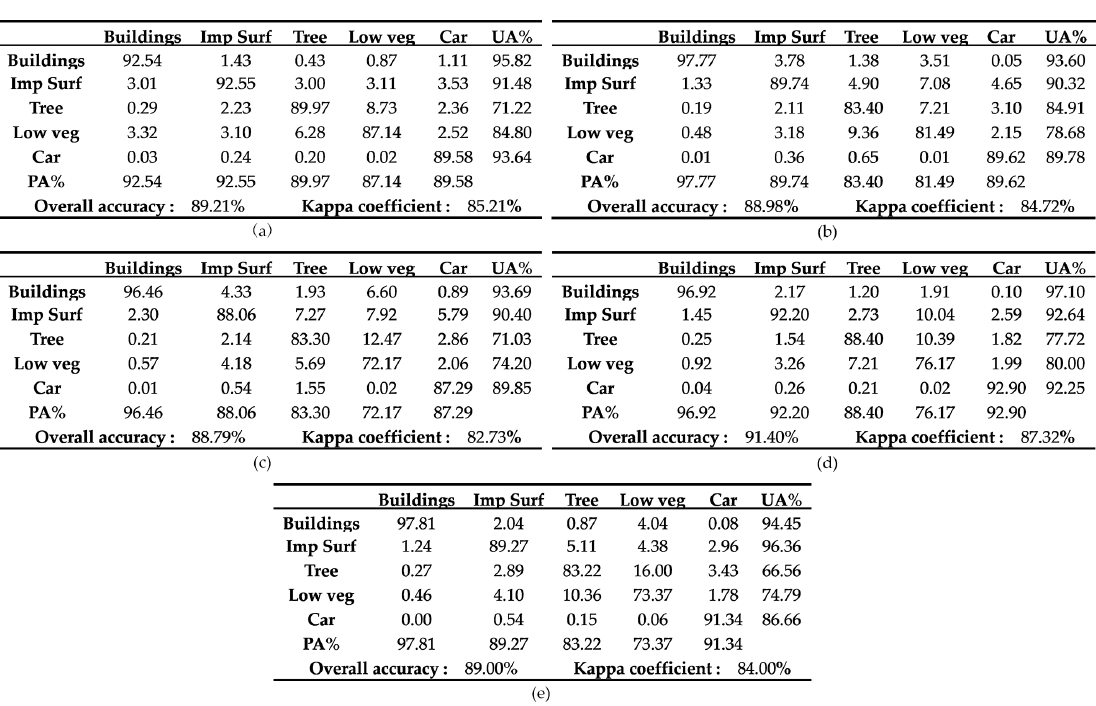
Figure 5. The confusion matrix of five validation images. ( a–e ) Confusion matrixes in five classes are calculated by the prediction results and ground truth images. The evaluation metrics in each subfigure contain producer accuracy (PA), user accuracy (UA), overall accuracy (OA) and kappa coefficient. The results in the confusion matrix represent the percentage.